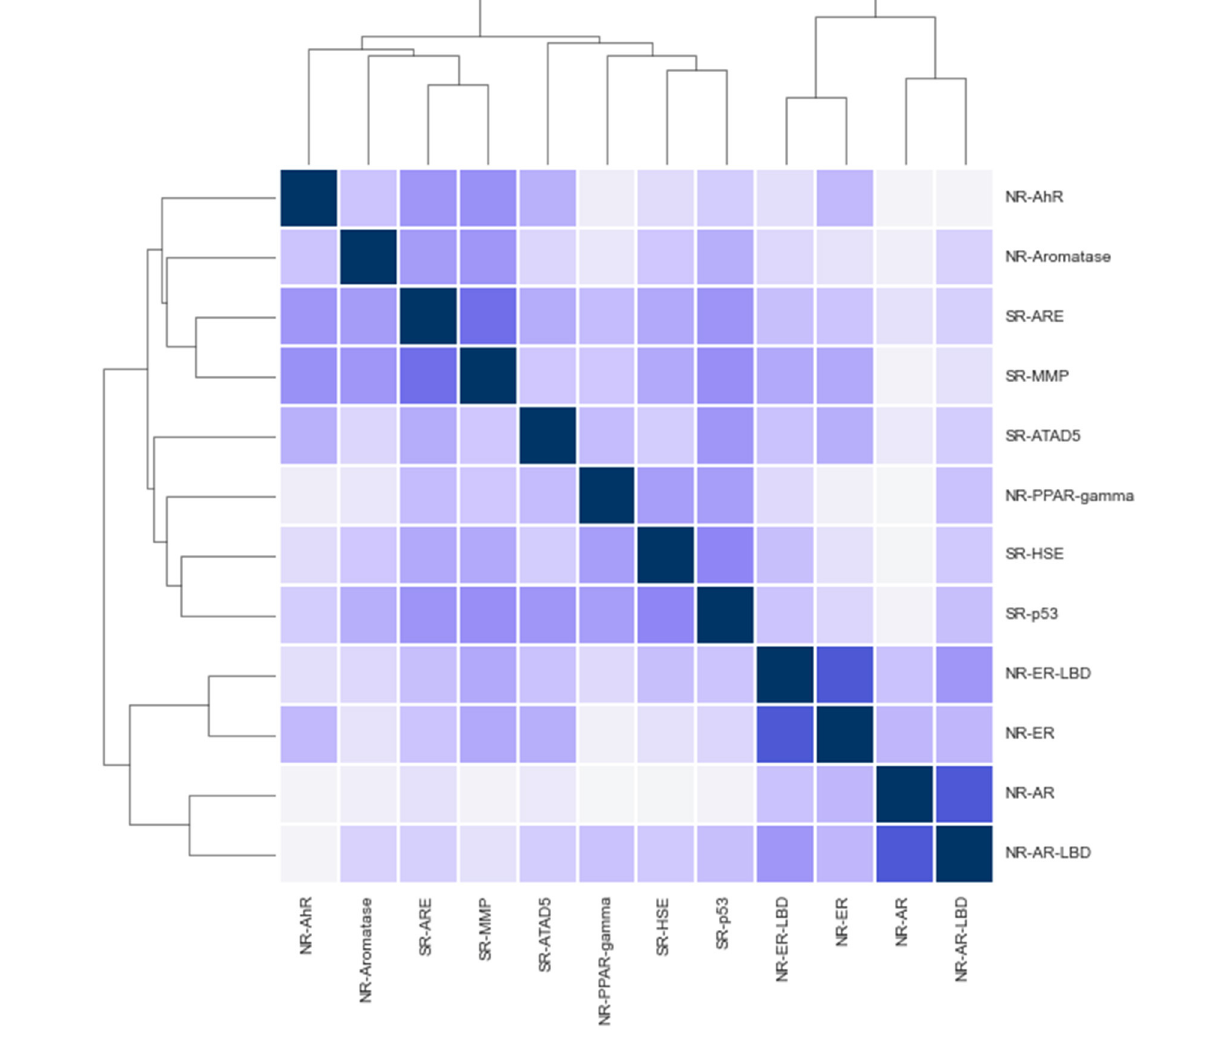
FIGURE 2 | Correlation and potential clustering of challenge